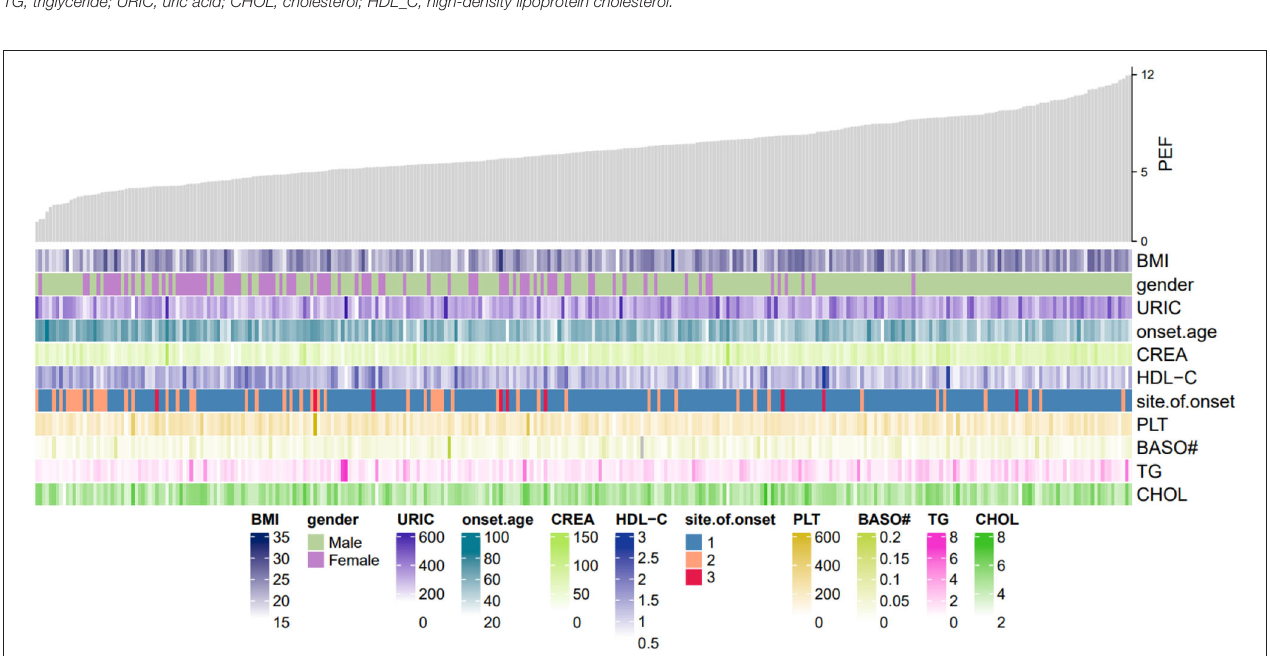
FIGURE 2 | Heatmap of PEF in this study. The gray shistogram represents values of PEF. Below the histogram are factors in the logistic regression model equation. The brightness of the color varied upon the value for continuous variables. PDF, peak expiratory flow; URIC, uric acid; BMI, body mass index; CREA,